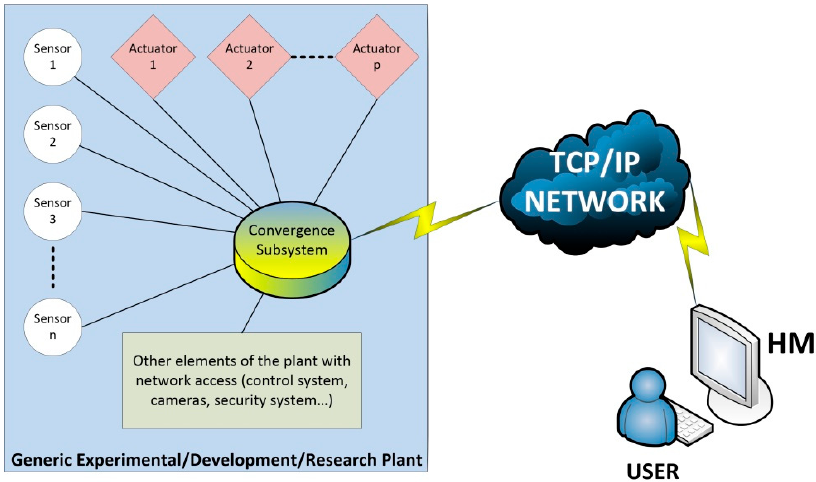
Figure 1. Simplified block diagram of a remotely accessed plant.